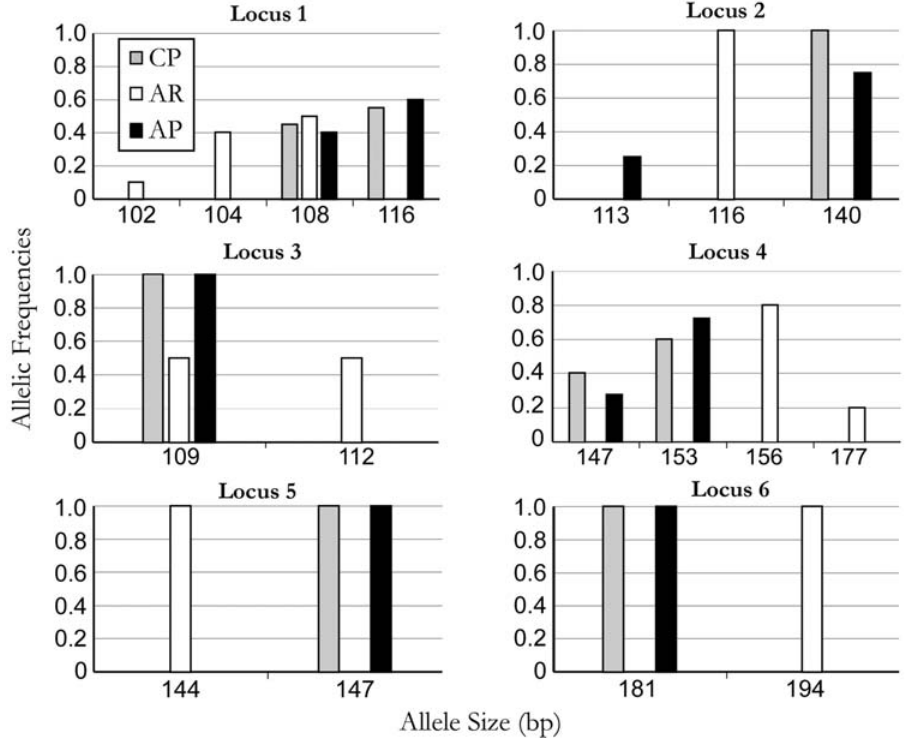
Figure 2. Microsatellite allelic frequencies. Panels represent the allelic frequencies of the six microsatellite loci ( Loci 1-6 ), which are examined for each mosquito strain (AP, AR and CP). In each panel, the Y-axis denotes allelic frequencies and the x-axis denotes the size of each fragment in base pairs. Loci 1-6 correspond to previously reported microsatellite loci AP1-AP6 [17] (naming modified here to avoid ambiguity with mosquito strains).